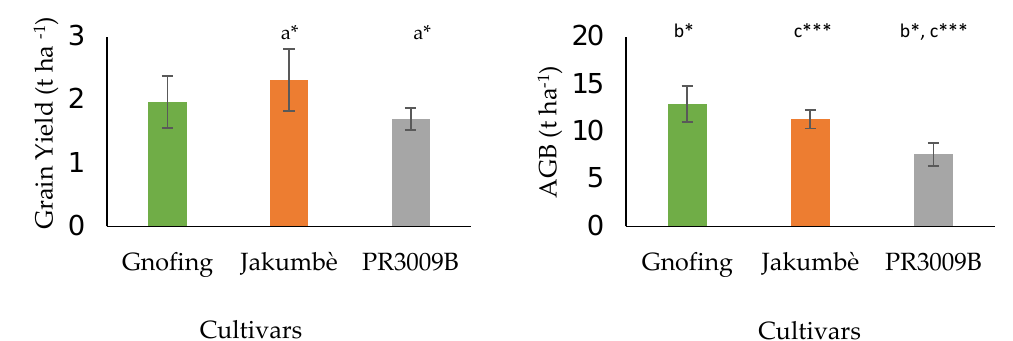
Figure 5. Grain yield and above ground biomass (AGB) of different sorghum cultivars in 2019 in N’Gakoro. n (no. of repetitions) = 5. Error bars = Standard Deviation. Two sample t-tests assuming unequal variances letters over cultivar mark significantly different relations between the both marked cultivars 0.01 ≤ p < 0.05: *, 0.001 ≤ p < 0.01: **, p < 0.001: ***.